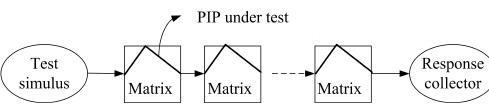
Figure 9. Traditional cascaded test